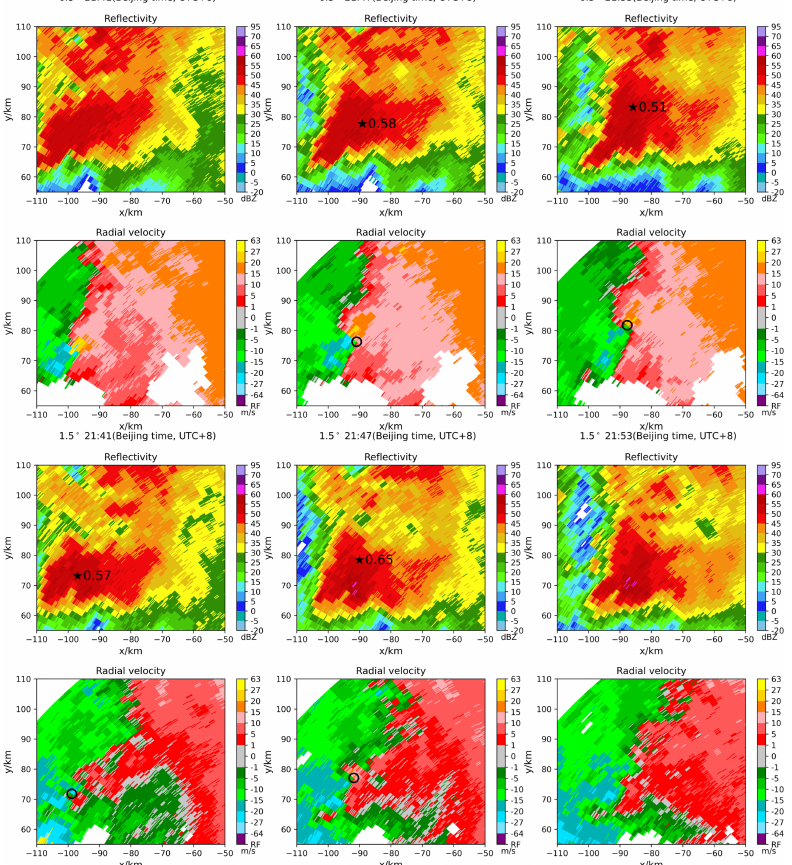
Figure A4. The TDA-RF detection results on radar Z9515, 0.5 ◦ and 1.5 ◦ , Z9515-2020-0722 21:41 to 21:53 (UTC+8), the tornado was EF1. (asterisk corresponds to the identification center, and the value corresponds to the probability; the black circle has a radius of 1.5km centered on the identification result; no asterisk and circle indicate that the TDA-RF did not recognize the